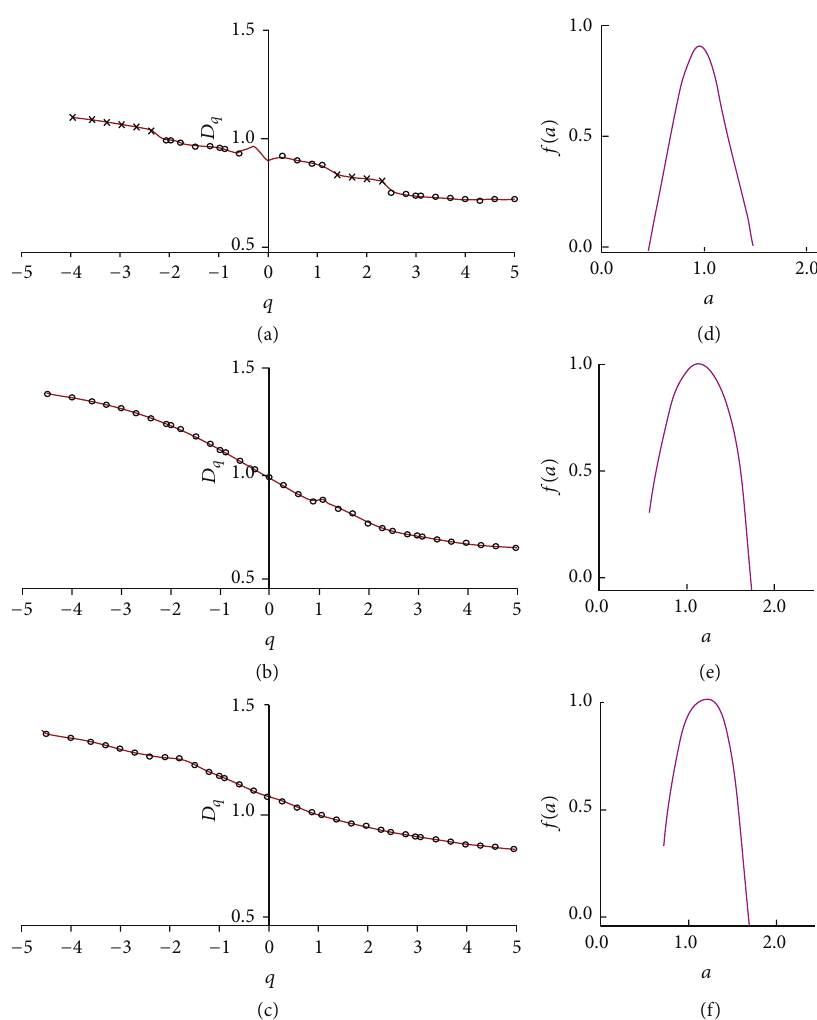
Figure 1: The three variation stages of the generalized dimension spectrum and singularity spectrum before 22 April 1974 Liyang earthquake (M5.5). (a) and (d) show the generalized dimension spectrum and singularity spectrum two years prior to this earthquake, respectively; (b) and (e) show the generalized dimension spectrum and singularity spectrum seven months prior to this earthquake, respectively; (c) and (f) show the generalized dimension spectrum and singularity spectrum four months prior to this earthquake, respectively. The curve of the generalized dimension spectrum in Figure 1(b) is steeper than the two others, and the value range of the singularity spectrum in Figure 1(e) is broader than the two